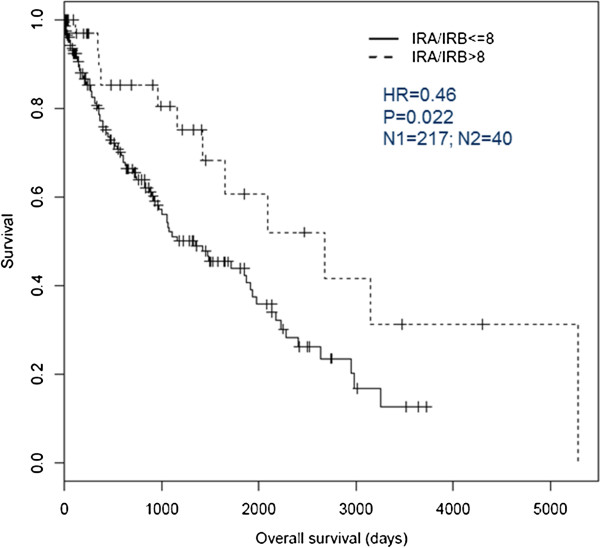
Kaplan-Meier plot comparing survival in LUSC patients with HIR versus LIR. Overall survival was adjusted by patient covariates including gender, smoking history, age at initial pathologic diagnosis, tumor stage, and treatment with chemotherapy. A P < 0.05 achieved in the analysis was considered to be statistically significant. The LUSC patients with HIR (dotted line) show a significant difference in survival compared to those with low ratio (dashed line) (hazard ratio, 0.457; 95% CI [0.23, 0.89]; P = 0.022).